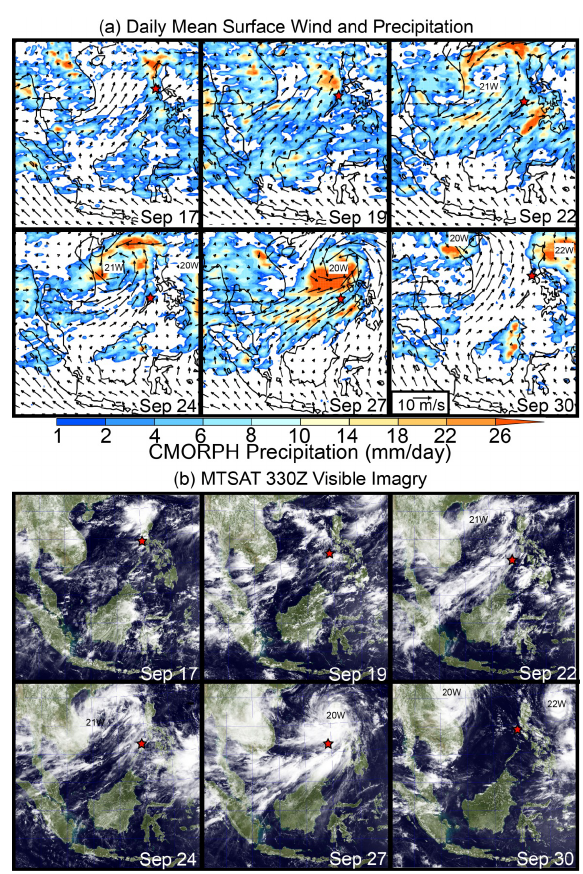
Figure 3. (a) Daily NOGAPS surface winds with CMORPH pre- cipitation for 6 days throughout the cruise demonstrating key meteorological and aerosol modes. (b) Corresponding NexSat 03:30UTC/11:30LST MTSAT visible imagery with synthetic color background. Ship location at satellite imagery time is located by a red